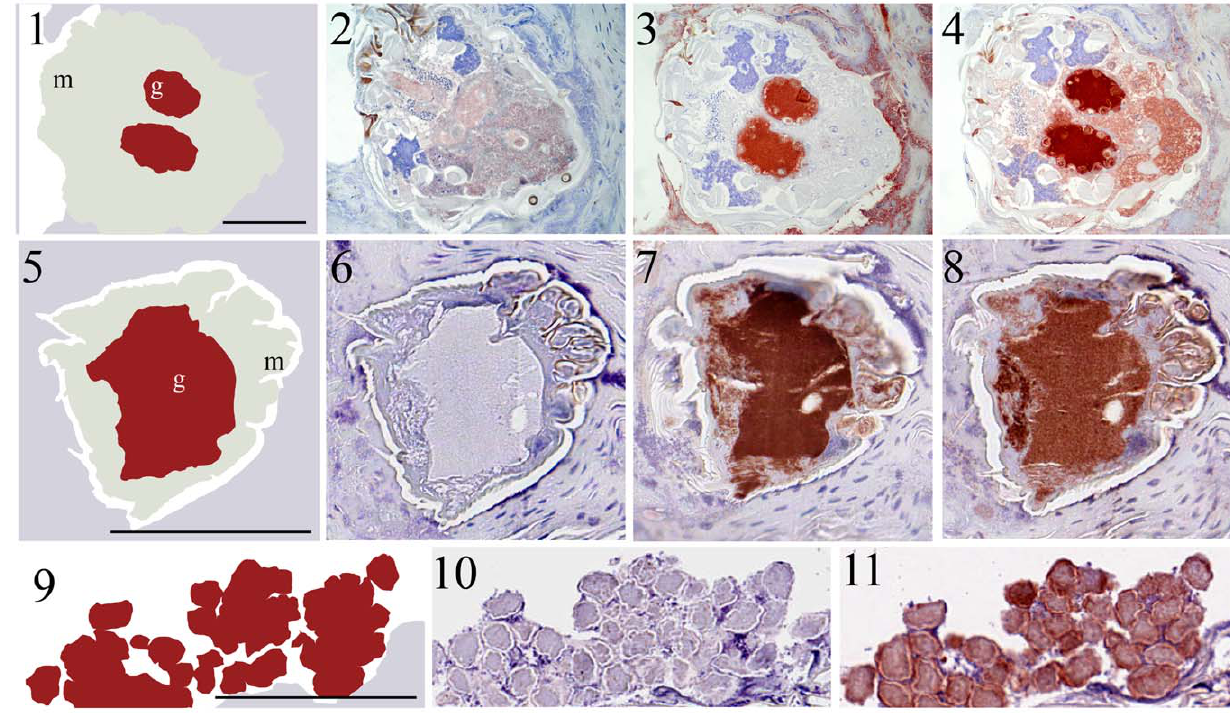
Figure 3. Immunolocalization of SMSs and IgG in scabies mite-infested human skin. Schematic diagrams 1 and 5 outline the features visible in serial histological sections through a scabies mite in infested human skin. Red staining indicates binding of antibody to protein. Section 2 and 6 probed with pre-immune mouse serum as a negative control remained unstained, while equivalent regions were detected in section 4 and 8 when probed with anti-human IgG, a marker for mite gut [9], and in section 3 and 7 when probed with antibodies against SMSB4 and SMSB3, respectively. Schematic diagrams outline the features visible in serial histological sections through human epidermis containing scabies mite feces 9 . Section 10 probed with pre-immune mouse serum as a negative control remained unstained, while equivalent regions were detected in section 11 when probed with anti-SMSB3 and in section 12 with anti-IgG. Staining of feces was also seen in equivalent experiments performed with antibodies against SMSB4 (not shown). Immunohistological co-localization of SMSs and host IgG indicated that both serpins are localized in the mite gut and mite feces within the burrows. b, burrow; f, feces; g, gut; m, mite. Scale bars (100 m M) indicate the magnification level.